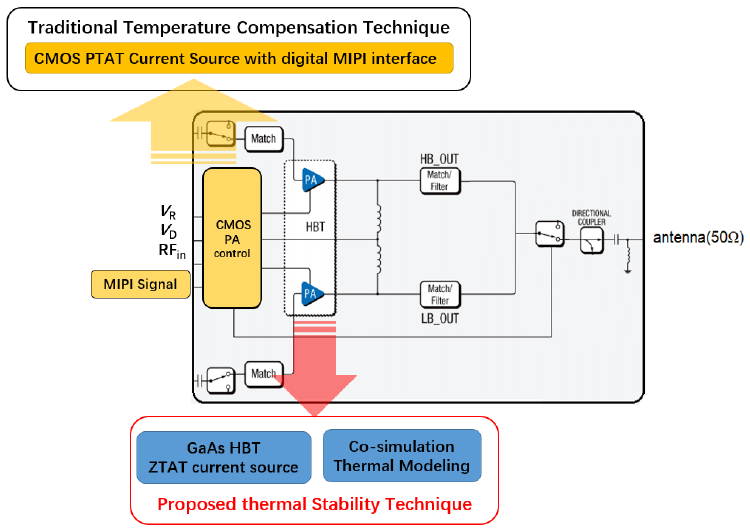
Figure 1. Functional diagram of PA with different temperature compensation techniques.